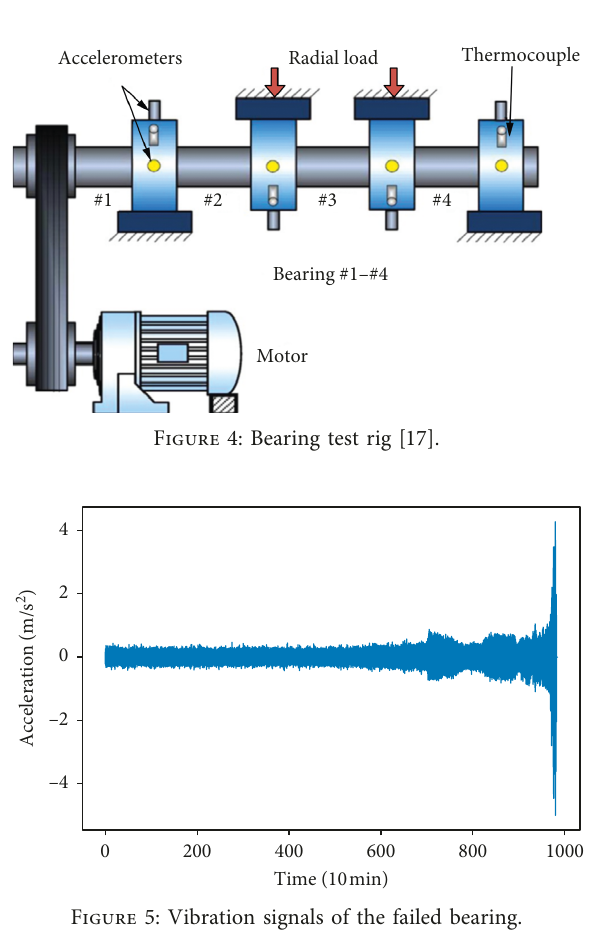
Figure 5: Vibration signals of the failed